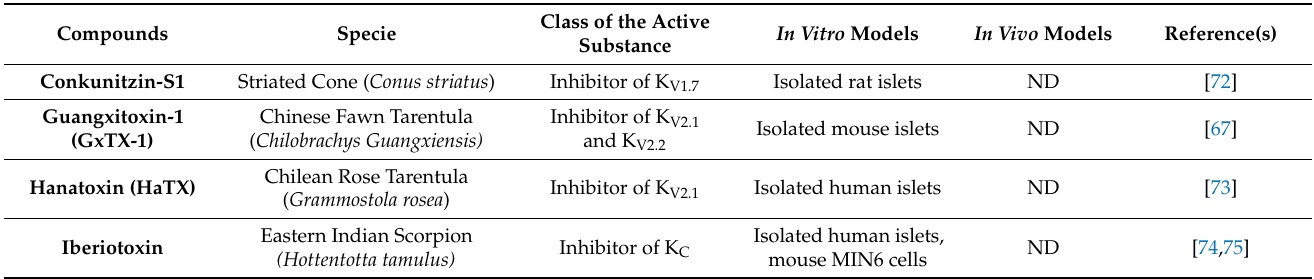
Table 2. Calcium-dependent potassium (K C ) or voltage-dependent potassium channels (K V ) inhibitor peptides that stimulate insulin secretion.